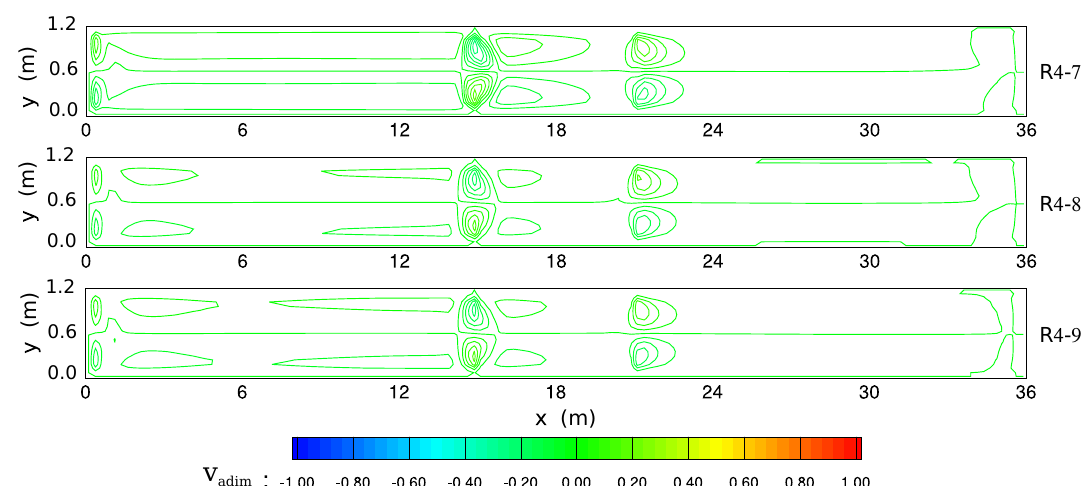
Figure 5. V velocity component in the surface layer for the three cases. Where v = V/V adim max .